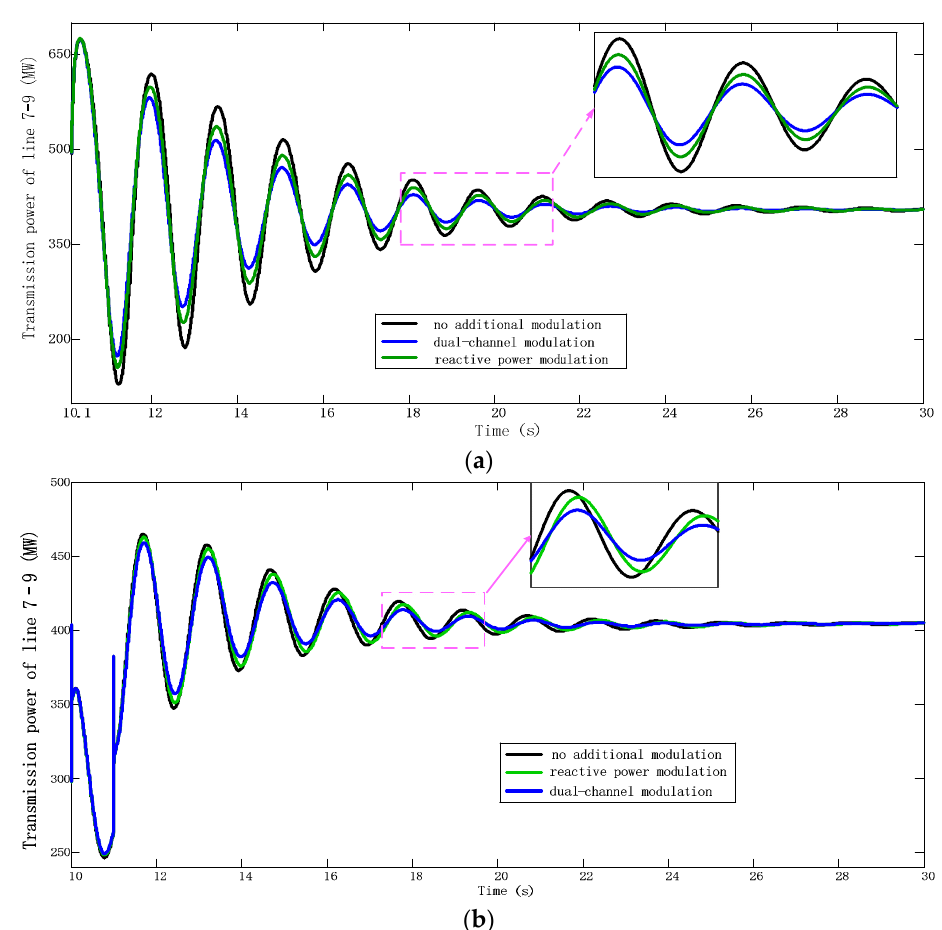
Figure 10. ( a ) Transmission power of Line 7–9 at Case A; ( b ) Transmission power of Line 7–9 at Case B.